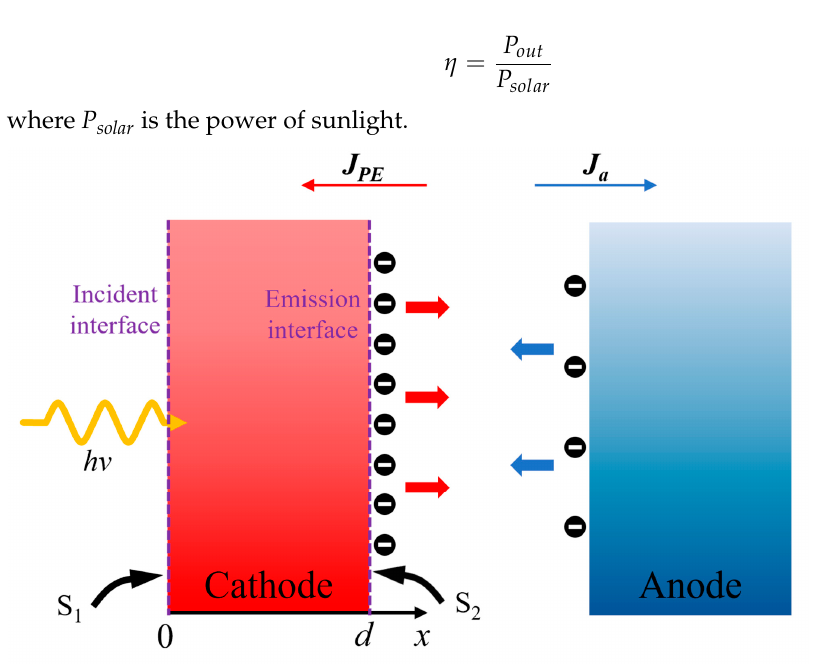
Figure 2. Initial ( x = 0) and boundary ( x = d ) conditions for the one-dimensional continuity equation.